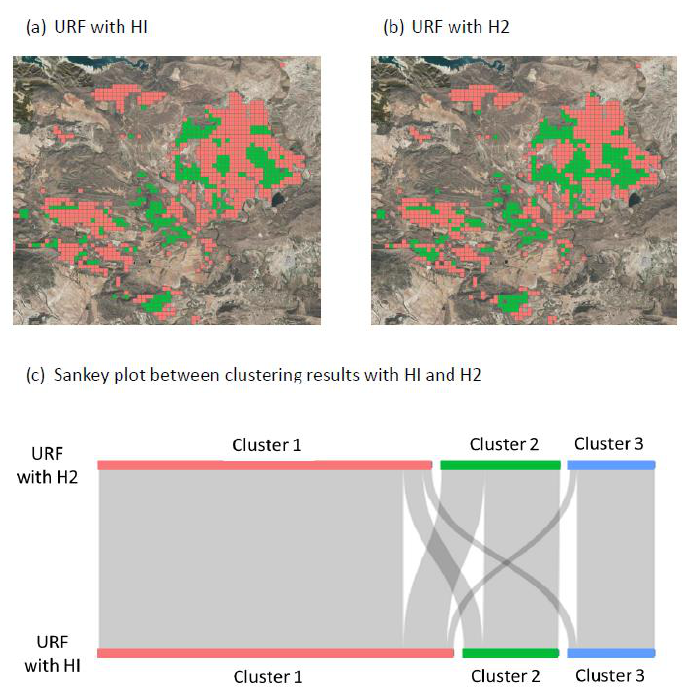
Figure 9. ( a ) On the top are the clustering results of URF in the Murcia-NW when HI ( a ) or H2 ( b ) was used, showing cluster 1 and 2 present in this region, while cluster three was not present in this area. ( c ) compares the differences in clustering when HI ( bottom ) and H2 ( top ) were used in URF for all the study areas.